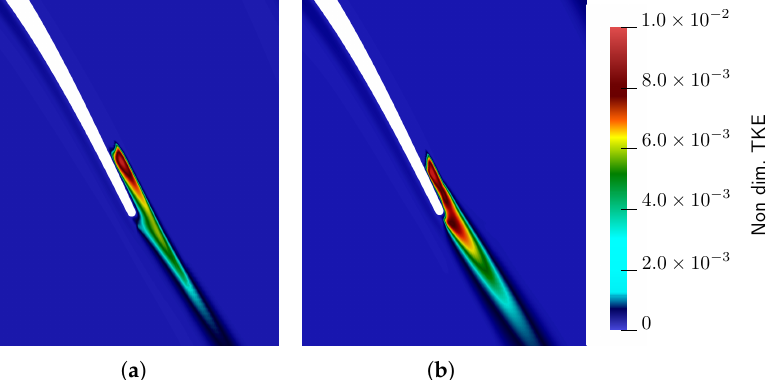
10 5 , x / C x , ms = 1.46). ×